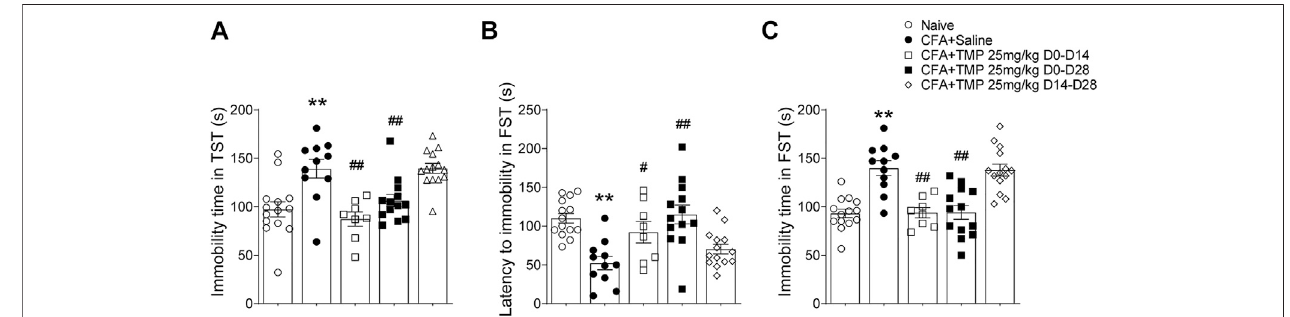
FIGURE 8 | Time dependent effects of TMP on depressive behaviors in CFA induced pain. (A) Effects on total immobility time in TST test with different TMP administration periods (25 mg/kg, i.p. D0-D14, D0-D28 and D14-D28 vs. saline). (B, C) Effects on latency to immobility (B) and total immobility time (C) in FST test with different TMP administration periods as indicated. Statistical analysis was performed by one way ANOVA, followed by Dunnett ’ s multiple comparisons (** p < 0.01, vs. Naïve; # p < 0.05, ## p < 0.01, vs. CFA+Saline).